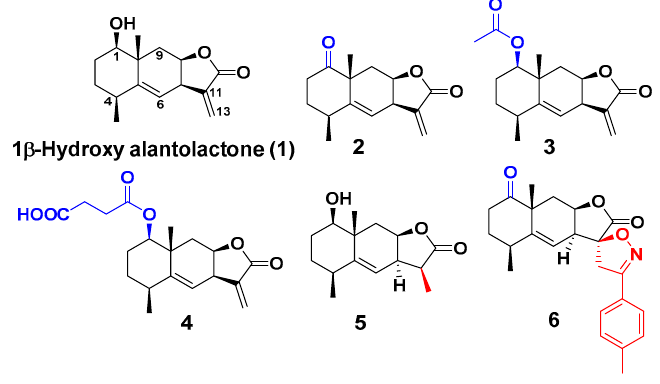
Figure 2. Semisynthetic derivatives of 1 β -hydroxy alantolactone ( 1 ).